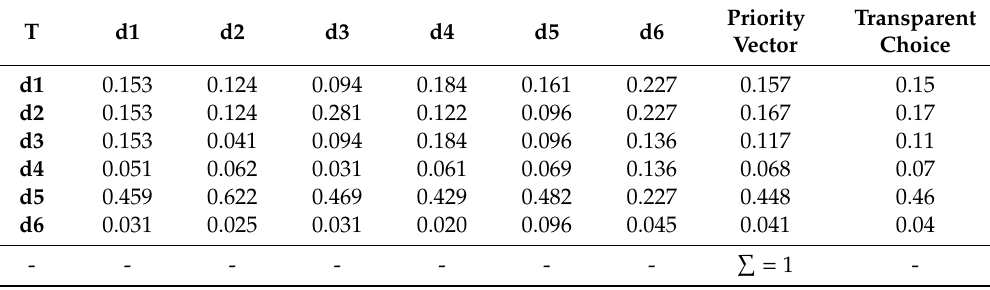
Table A8. Synthesised matrix for subcriteria associated with technological